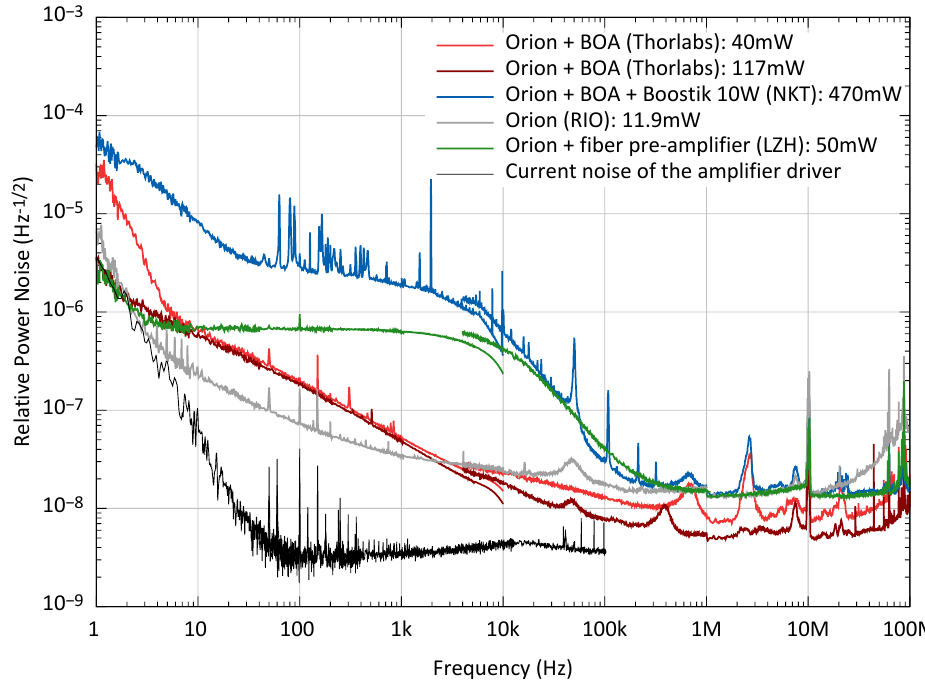
Figure 6. The free-running RPN at the output of the pre-amplifiers is shown. For all measurements, the Orion laser is used as the seed source (grey